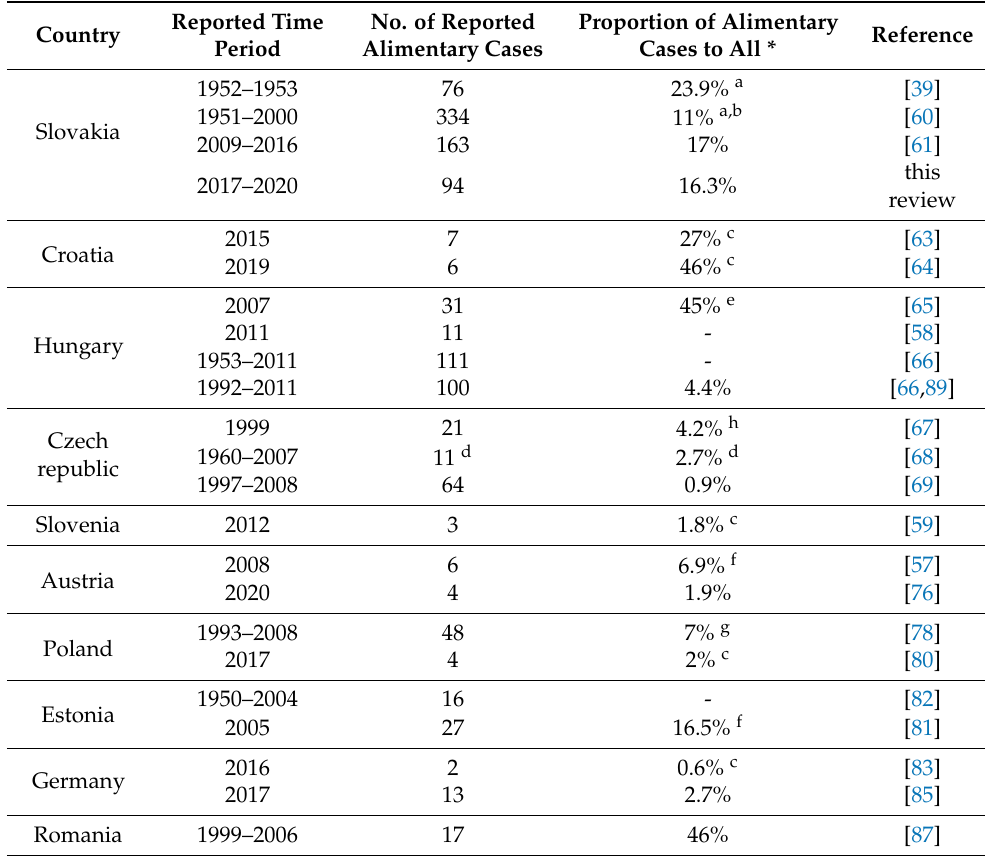
Table 1. Number of cases of alimentary infection of TBEV in European countries. Reported Time Country